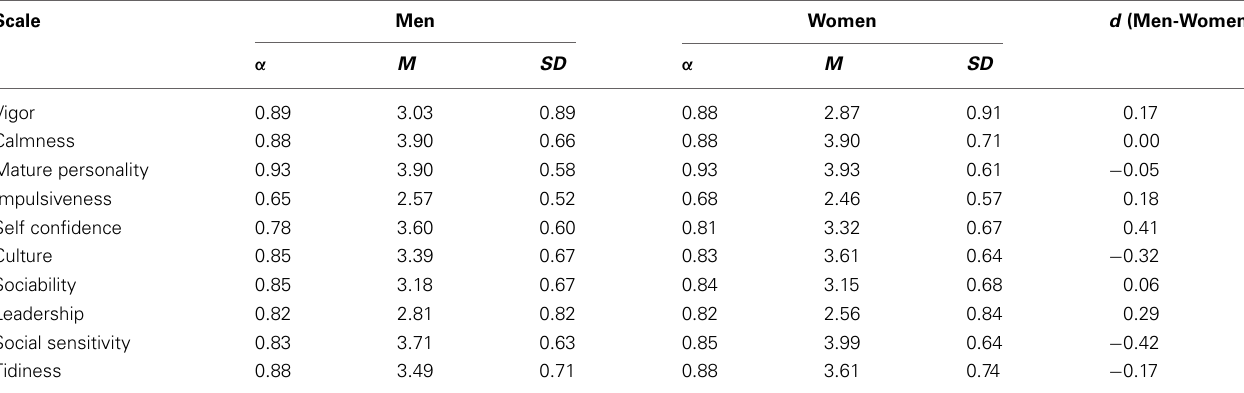
Table 2 | Reliabilities, means, and standard deviations in the Project Talent Personality Inventory Scales broken down by gender.